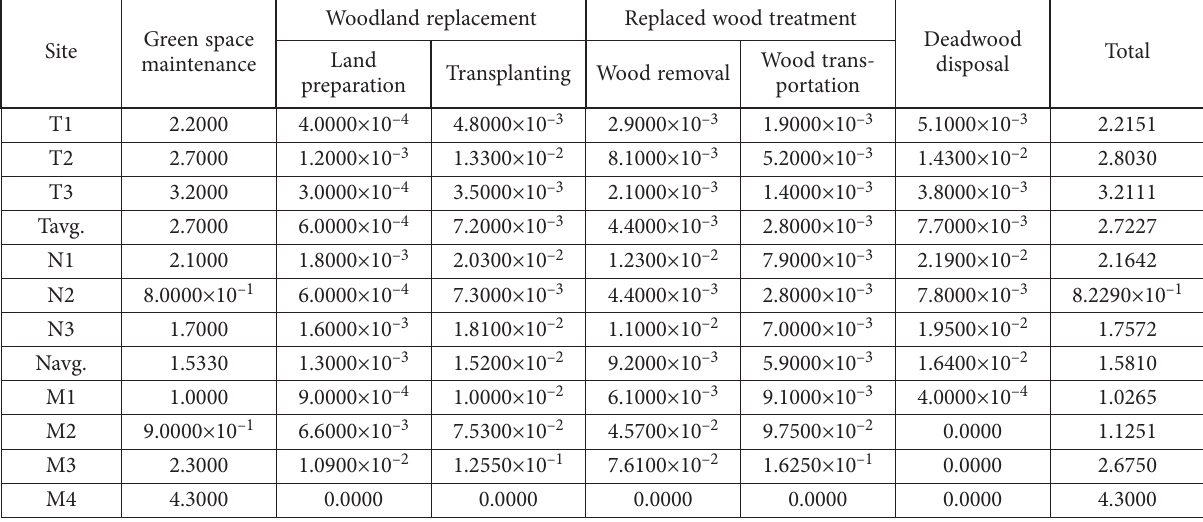
Table 9. GWP indexes of cemetery green space and various types of plant site maintenance